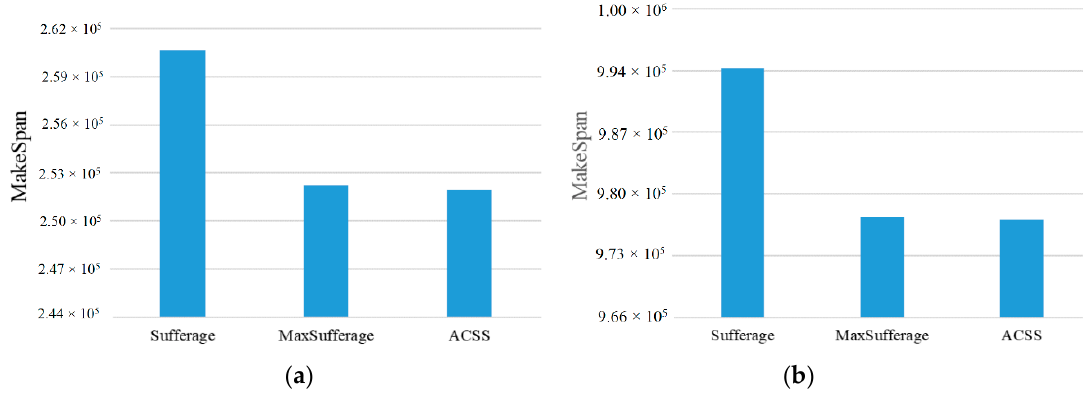
Figure 2. The comparison results of MakeSpan among Sufferage, MaxSufferage, and ACSS algorithms for ( a ) n = 4 and number of tasks = 50 and ( b ) n = 4 and number of tasks = 100. In general, the value of the load balancing index is a number between 0 and 1, with 0 being the worst load balance and 1 being the optimal load balance.